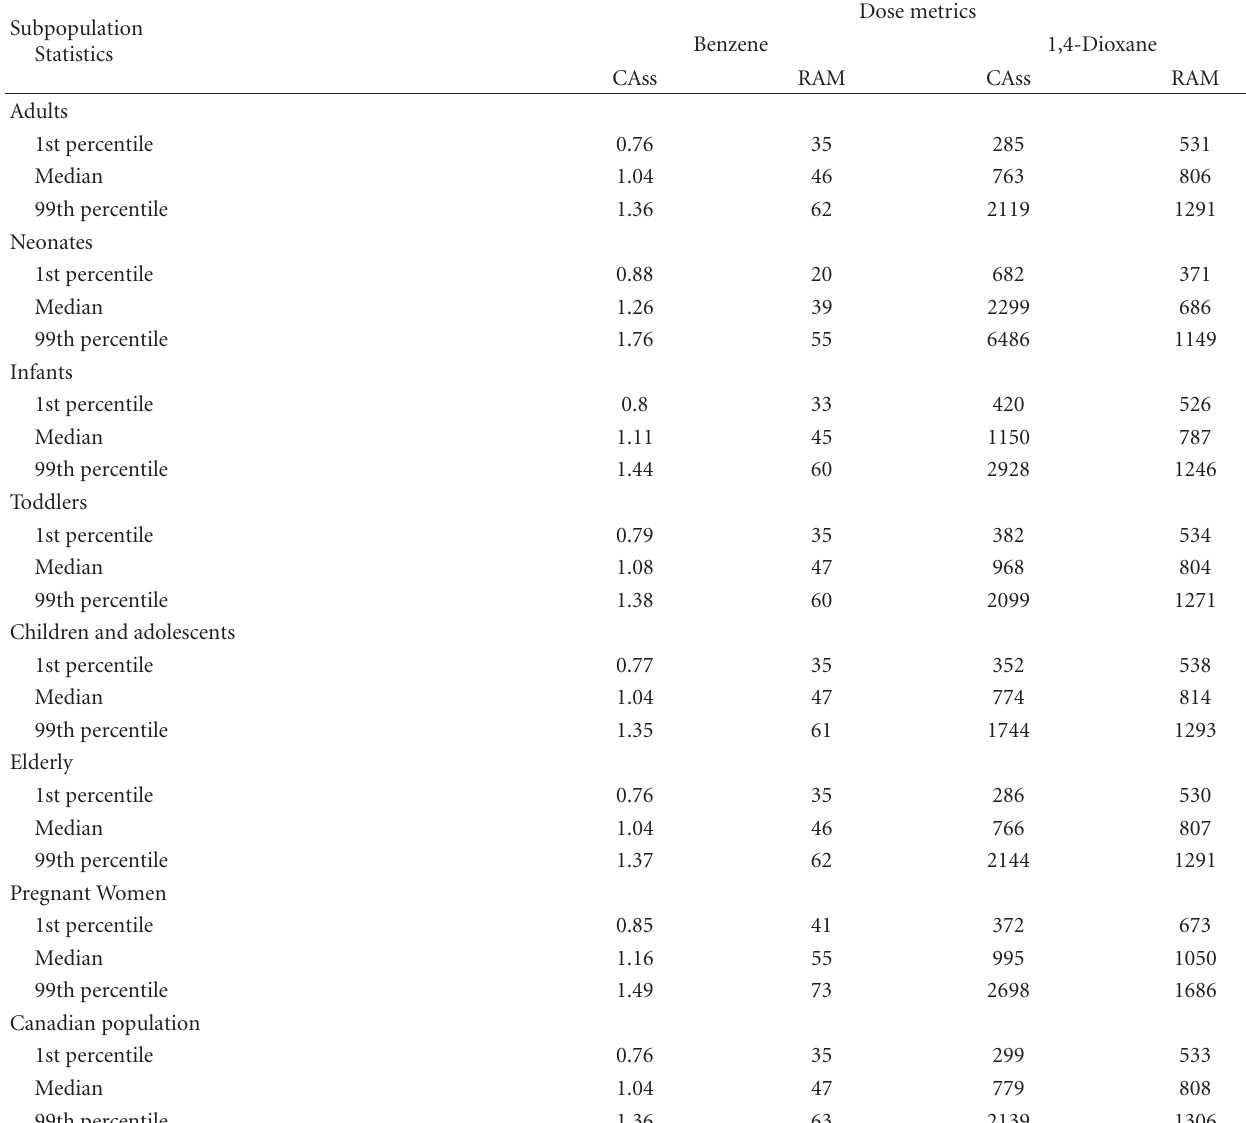
Table 4: Distribution statistics of various dose metrics in each subpopulation based on 100,000 Monte Carlo iterations and the entire Canadian populations for constant inhalation